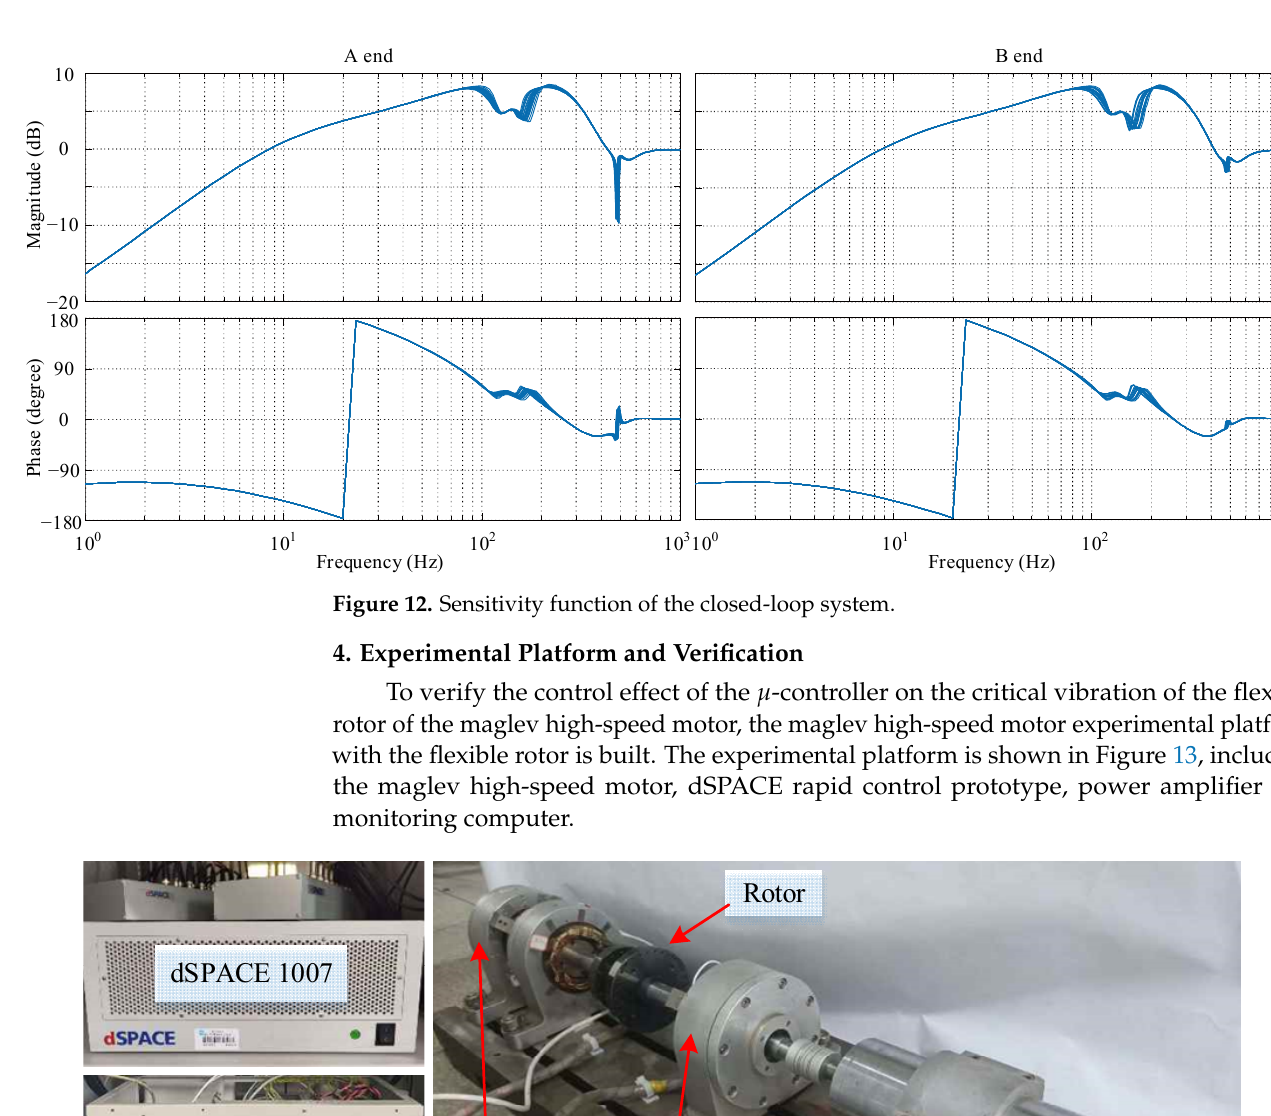
Figure 13. Maglev high-speed motor experimental platform with the flexible rotor.